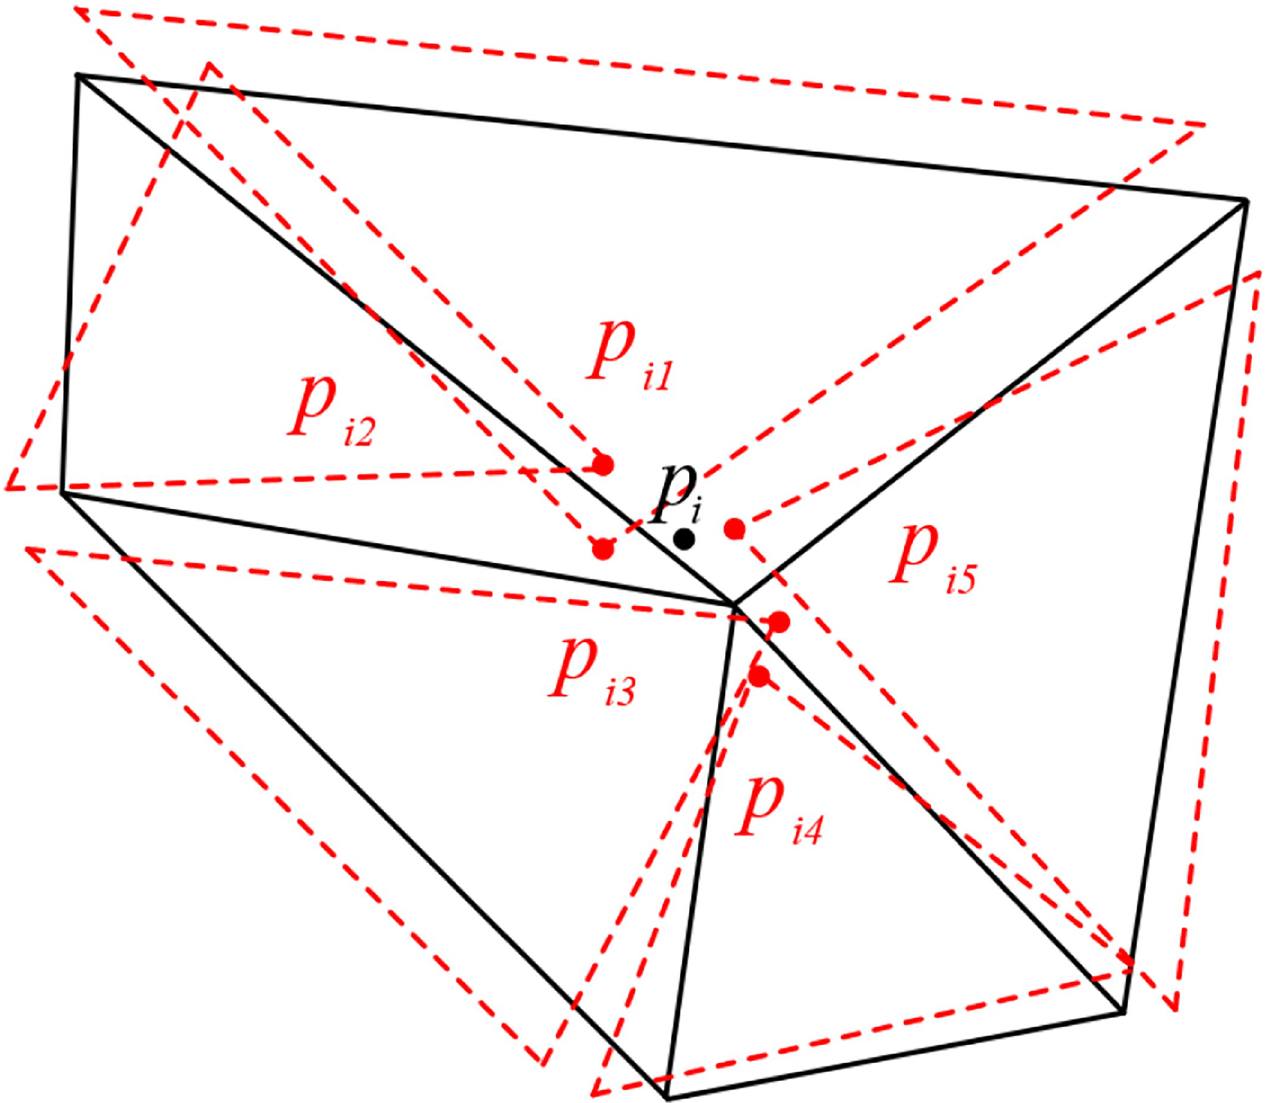
Fig 4. Assembly operation of one node in EAS smoothing. The node p i has the valence of 5, its 5 original included elements are represented in black solid lines; after the first two stages of EAS method, 5 elements are transformed into 5 isolated ones in red dotted lines, and 5 replicas of p i are represented in red thick point, denoted as p ij